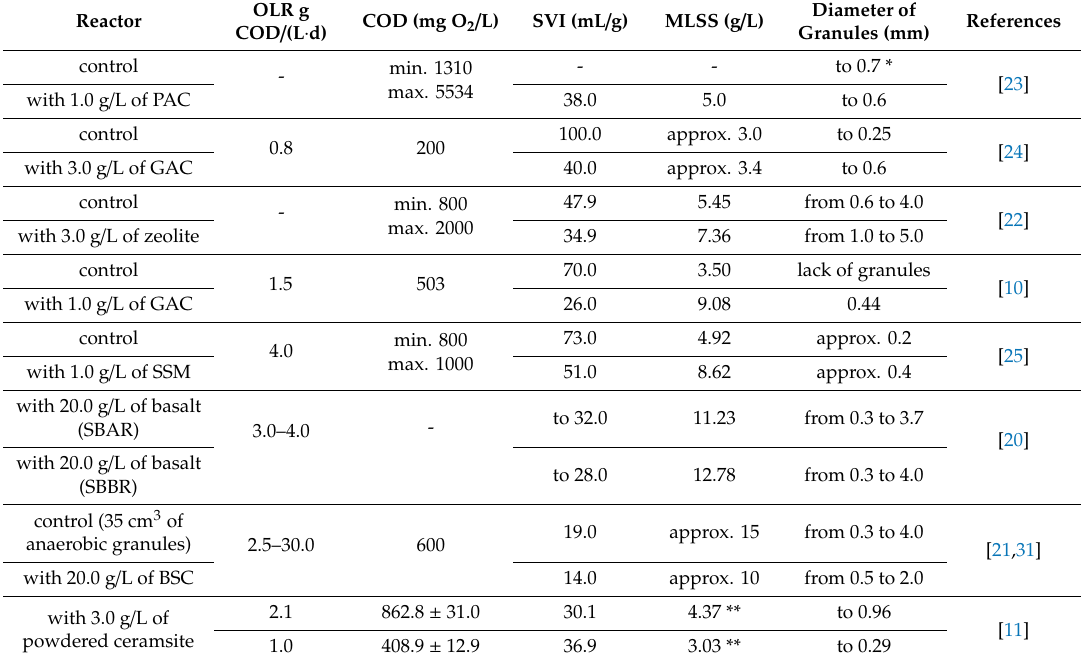
Table 5. Comparison of biomass parameters in reactors supported by powdered substances with those of a control